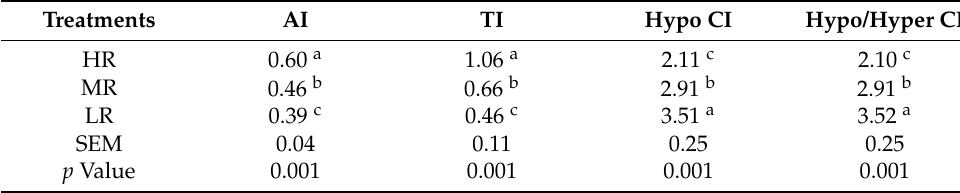
Table 6. Effect of ω -6/ ω -3 ratio on egg health indices from LSL laying hens. Treatments AI